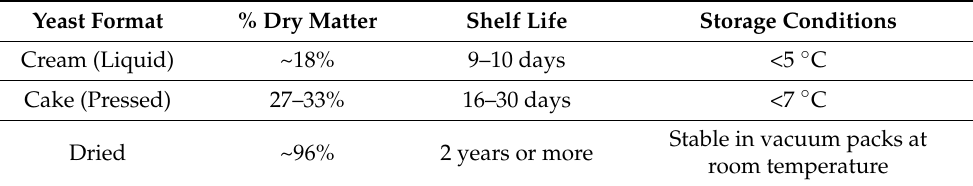
Table 6. Distilling yeast